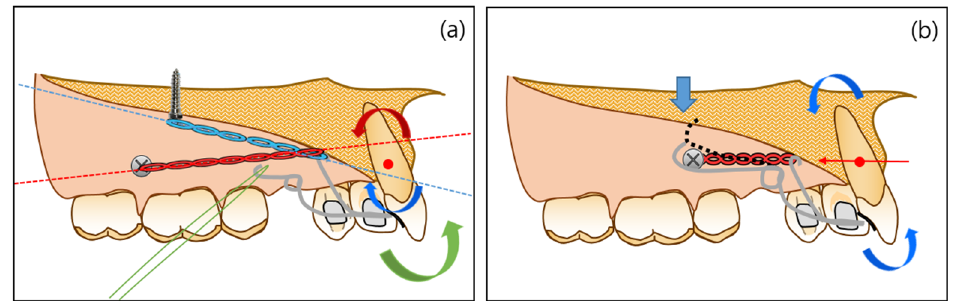
Figure 9. Comparison of different force systems generated with different designs of double J Retrac- tors (DJRs): ( a ) direction of force that passing above and below the center of resistance (CR) of the anterior teeth and application of intermaxillary elastics; ( b ) direction of the force that passes through the CR of the anterior teeth and activation of helical torquing spring. Redrawn with permission from Am J Orthod Dentofacial Orthop [22].